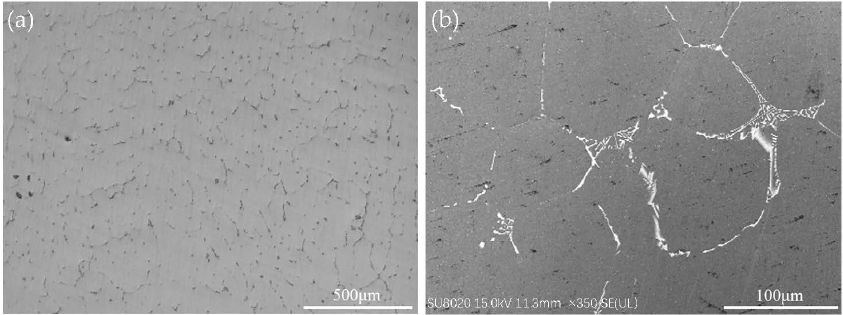
Figure 3. Microstructure of the as-cast Al-5Zn-0.03In-1Er alloy: ( a ) OM image, ( b ) SEM image. The representative microstructure of the as-cast Al-5Zn-0.03In-1Er alloy is shown in 4b–e. It is obvious that an Er-rich phase occurred along the Al grain boundaries.